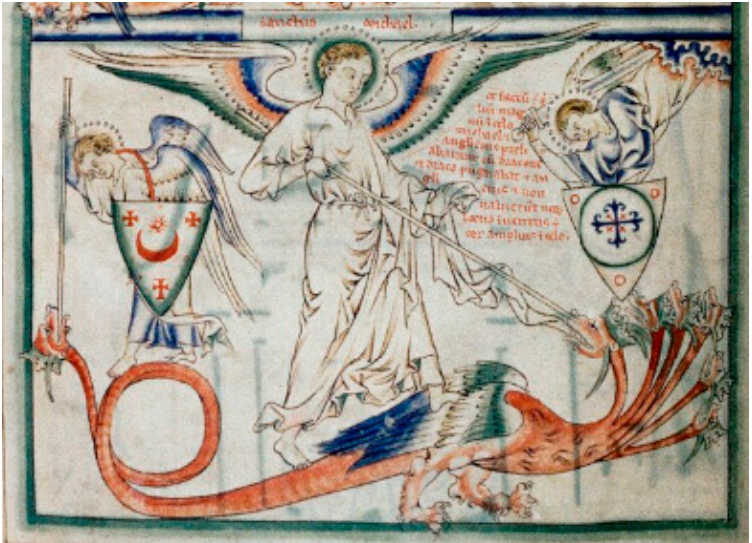
Figure 2. Bodleian Apocalypse (Oxford, Bodleian Library MS Auct D.4.17). Fol. 8 v , c. 1255, © Bodleian Libraries, University of Oxford.